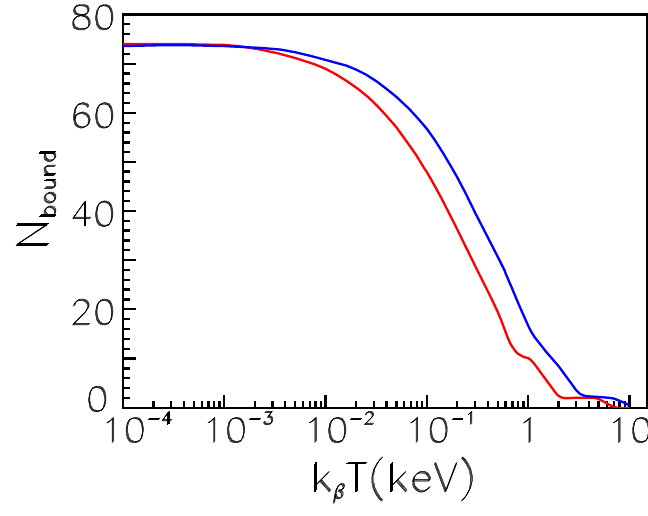
( k T ) for the tungsten ion in plasmas of Figure 13. A number of bound electrons N bound β = 1 . 93 g / cm 3 ; red, ρ = 0 . 01 g / cm 3 . various densities. Blue, ρ 1 2 Table 8. Spectrum of energies ε and level populations N for the tungsten ion in plasmas i i = 1 . 93 g/cm 3 , R = 6.339 a.u. and ρ = 0 . 01 g/cm 3 , R = 36.635 a.u. with densities ρ 1 WS 2 WS ρ (g/cm 3 )